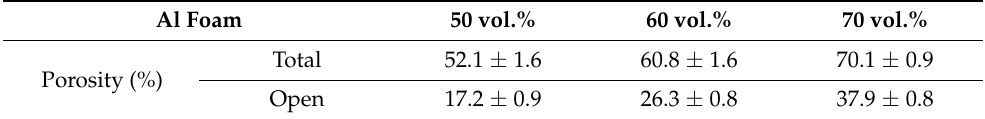
Table 2. Porosity values of sintered Al foams. Al Foam 50